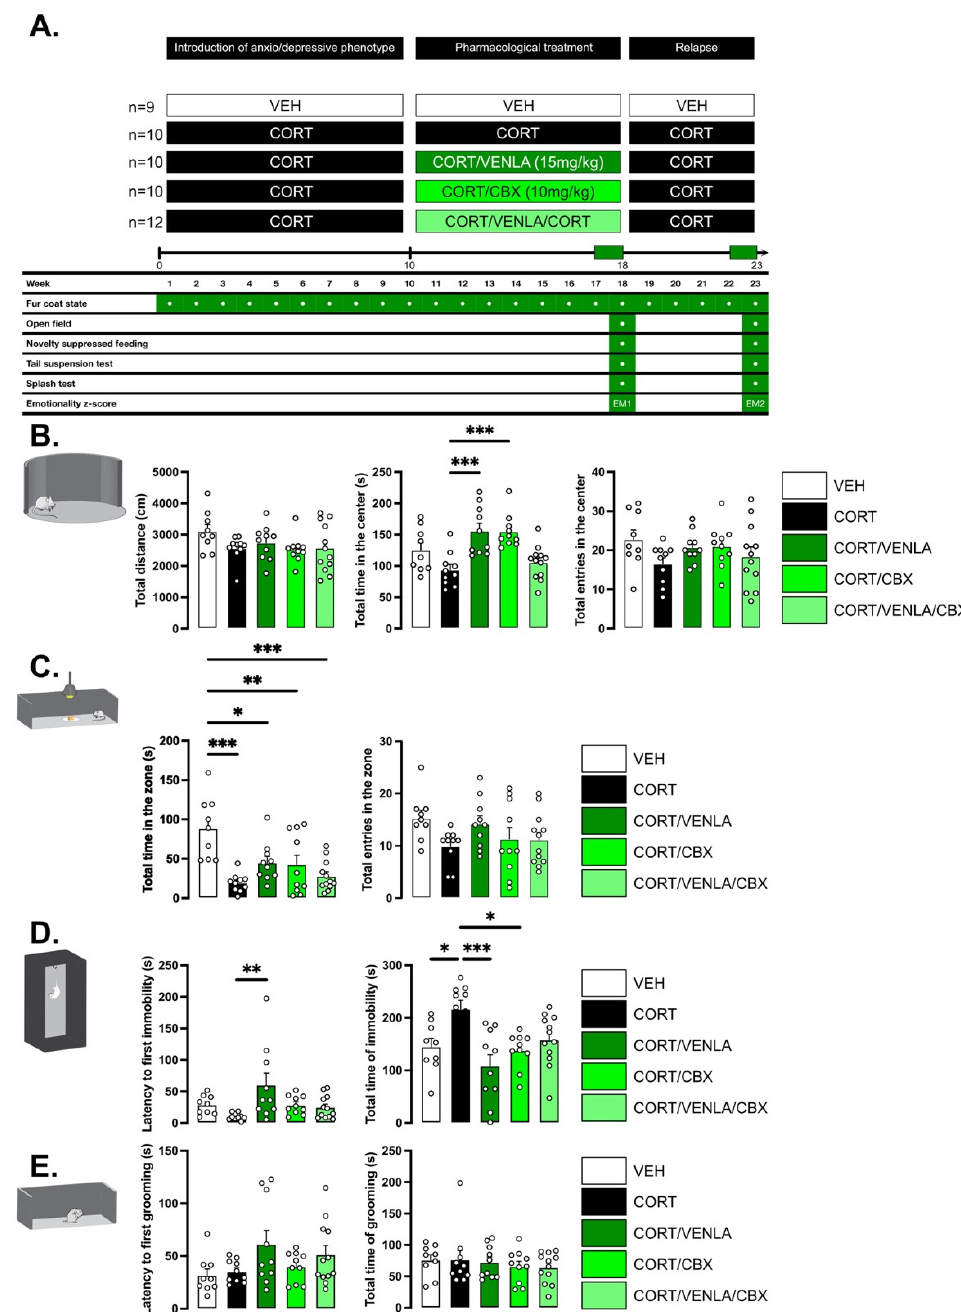
Figure 2. Anxio-/depressive-like behavior to study venlafaxine/carbenoxolone antidepressant effect in a mouse model of depression. ( A ) Design of experiment. Mice were chronically treated with VEH ( n = 9 animals) or to CORT ( n = 42) for 10 weeks. On Week 10, CORT group have been divided in four groups receiving either CORT ( n = 10), CORT + VENLA (15 mg/kg/day in the drinking water; n = 10), CORT + CBX (10 mg/kg/day; i.p.; n = 10) or the combination of the three of them CORT + VENLA + CBX ( n = 12). On Week 18, VENLA and CBX treatments were stopped, whereas CORT was maintained for all the groups. Emotionality z-score were calculated at Week 18 (EM1) and Week 23 (EM2) to respectively assess responsiveness and relapse to VENLA or VENLA + CBX treatment. ( B – E ) Anxio-/depressive-like behavior. Data are mean ± SEM of mice performances in the open field ( B ), novelty-suppressed feeding ( C ), tail suspension tests ( D ) and splash test ( E ). Asterisks indicate statistical significance on raw data. * p < 0.05, ** p < 0.01 and *** p < 0.001: Statistically different as indicated.